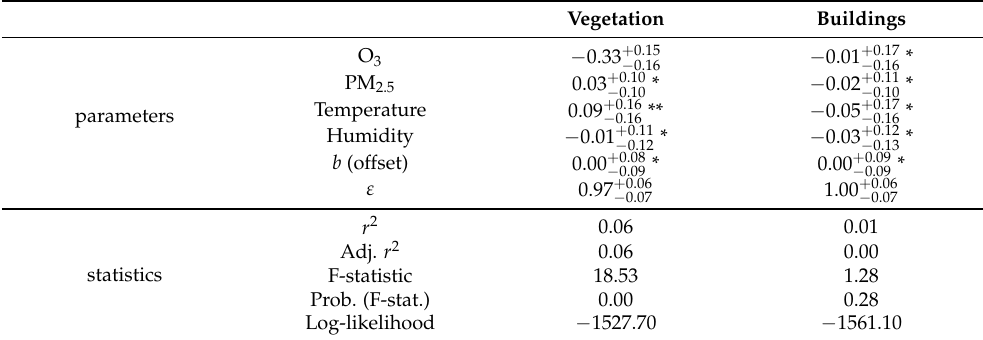
Table A2. Top: MCMC median and 3 σ uncertainty (including the full parameter covariance, derived from the MCMC posteriors of atmospheric coefficient parameters to model the PRI values. Bottom: Model evaluation statistics for the maximum likelihood solution for vegetation and